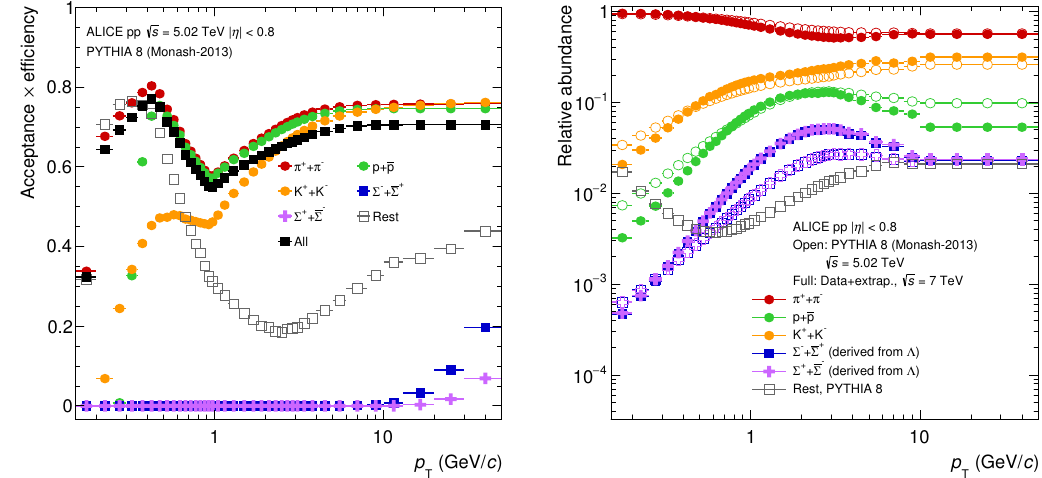
Figure 1 . Left: combined tracking e(cid:14)ciency and acceptance as a function of p T for di(cid:11)erent particle p species and the sum of all, obtained in Monte Carlo simulations of pp collisions at s = 5 : 02 TeV with PYTHIA 8 (Monash 2013 tune). For p T > 1 GeV/ c parameterizations are shown. The relative systematic uncertainties on parameterizations are small ( < 0 : 2%) and are not shown. The statistical uncertainties for p T < 1 GeV/ c are smaller than the symbol size ( < 0 : 5%). Right: the p relative particle abundances as a function of p T in Monte Carlo (open symbols, for s = 5 : 02 TeV) p and in data (full symbols, for s = 7 TeV) [35{37]. The data are extrapolated beyond the range of the measurements (see description in the text). The statistical and systematic uncertainties (combined < 1 : 6%) are not